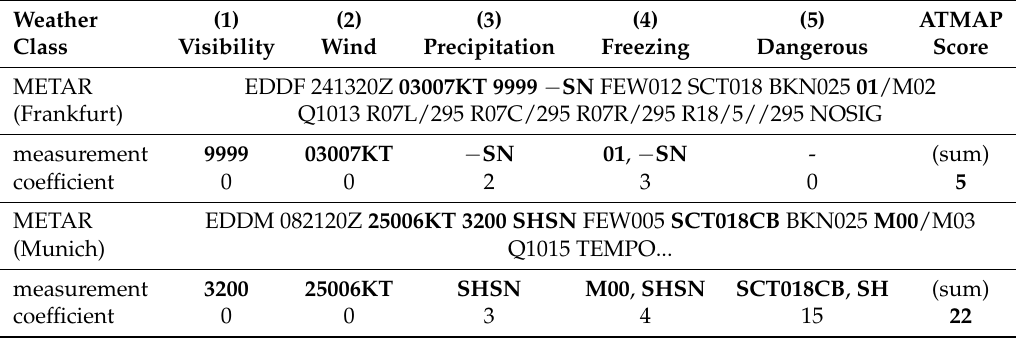
Table 4. Calculation of ATMAP weather score using local airport METAR messages from Frankfurt and Munich